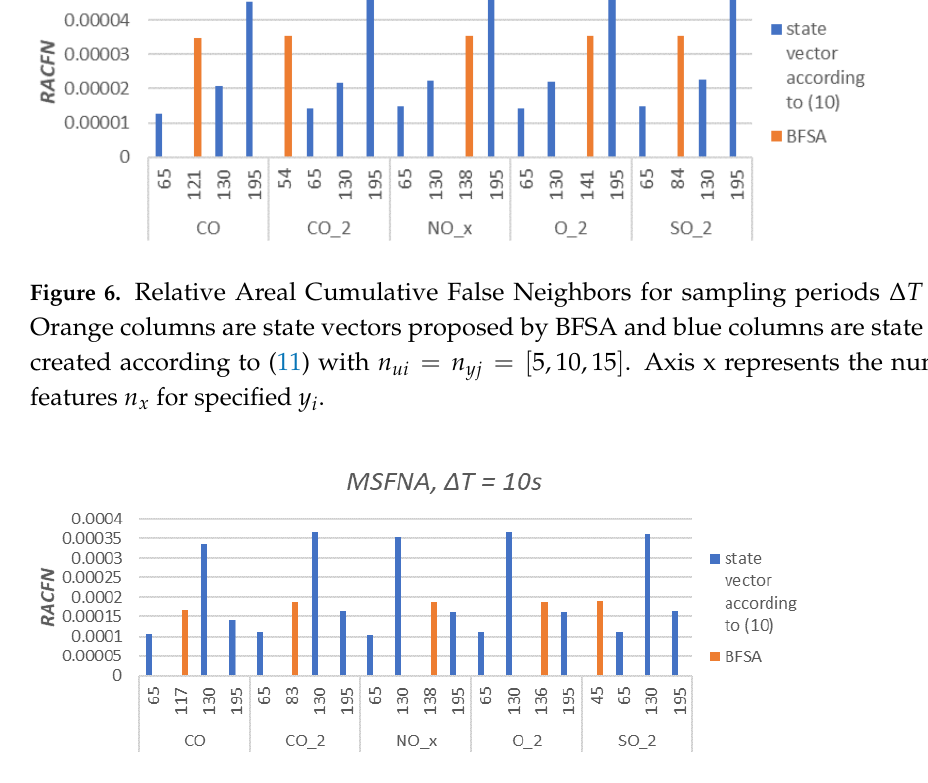
Figure 7. Relative Areal Cumulative False Neighbors RACFN for sampling periods ∆ T = 10 s. Orange columns are state vectors proposed by BFSA and blue columns are state vectors created according to (11) with n ui = n yj = [ 5, 10, 15 ] . Axis x represents the number of features n x for specified y i .